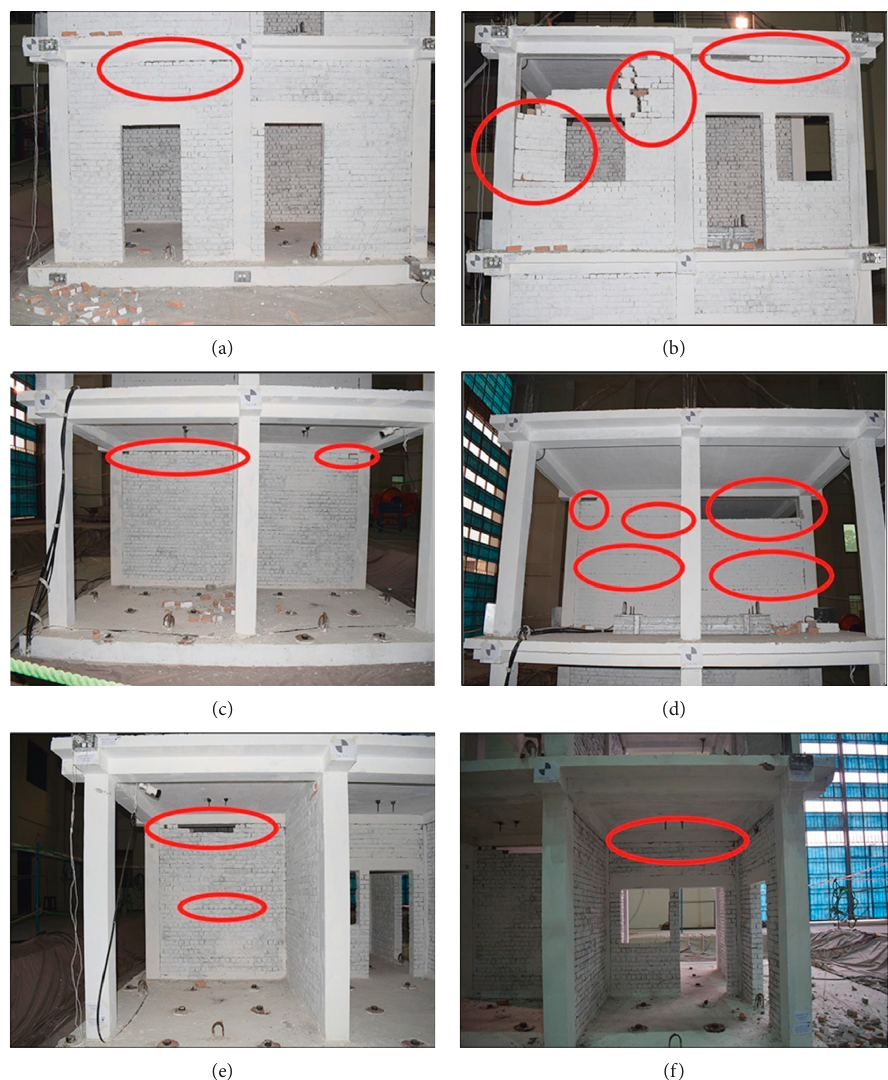
Figure 14: Damage observations of URM walls after Test Run-2. (a) Exterior infilled frame of first storey. (b) Exterior infilled frame of second storey. (c) Interior infilled frame of first storey. (d) Interior infilled frame of second storey. (e) Out-of-plane solid infilled frame. (f) Out-of-plane with openings infilled